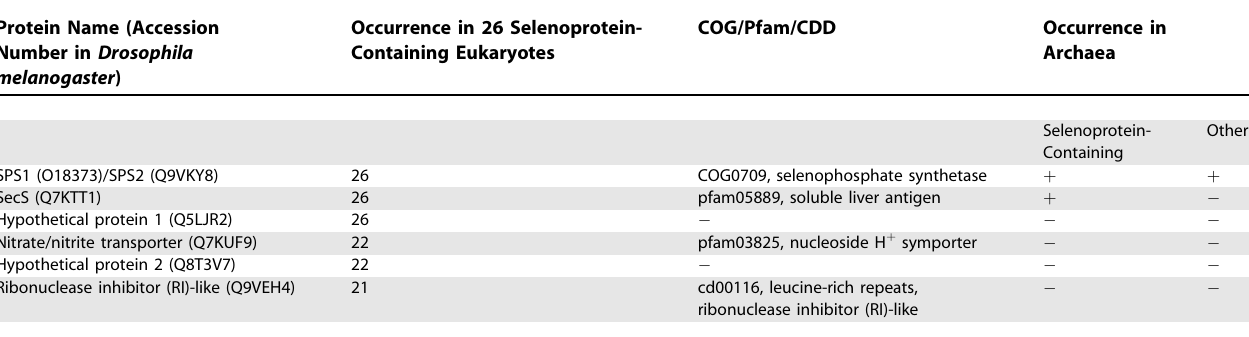
Table 1. Phylogenetic Profiles of Eukaryotic Proteins That Are Present Exclusively in Selenoprotein-Containing Eukaryotes Occurrence in 26 Selenoprotein- Protein Name (Accession Containing Number in Drosophila melanogaster )